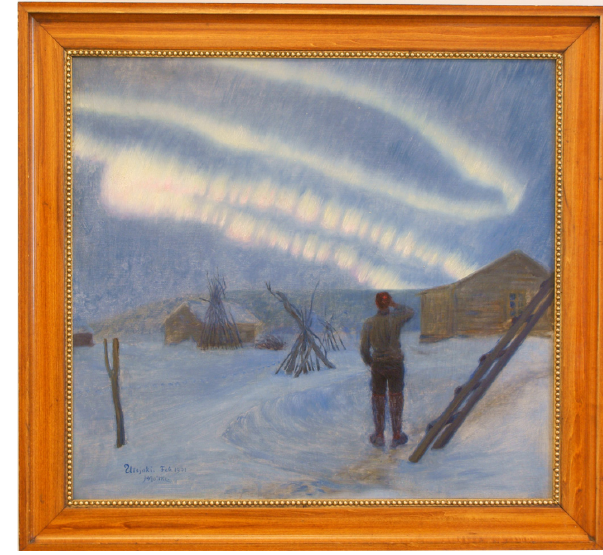
Figure 21. Aurora over Utsjoki on 22 February 1901 at 18:35h by Moltke (Photo,